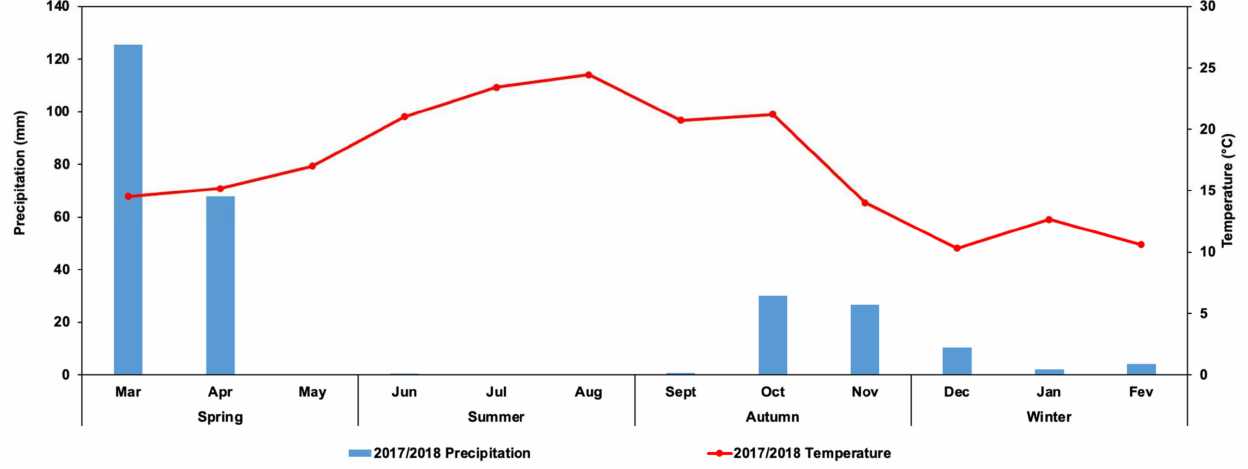
Figure 2. Monthly mean of temperature ( ◦ C) and precipitation (mm) in the study area (Northern Morocco) based on FiledClimate database (regional weather